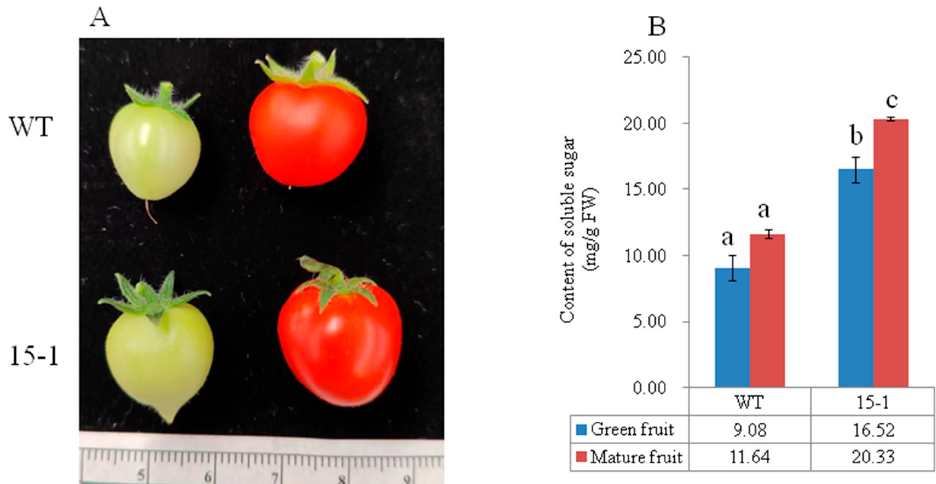
Figure 7. Overexpression of AcSWEET11 improved soluble sugar in micro-tom tomato. ( A ) Devel- opment of tomato fruit in WT and transgenic tomato lines (15-1). ( B ) Soluble sugar content of WT and transgenic tomato lines (15-1). Blue columns presented in green fruit, red columns presented in mature fruit. Values denoted three biological replicates, and vertical lines represented as mean of SD. Different letters denoted significant difference with one-way ANOVA test by Tukey’s test ( p < 0.05).